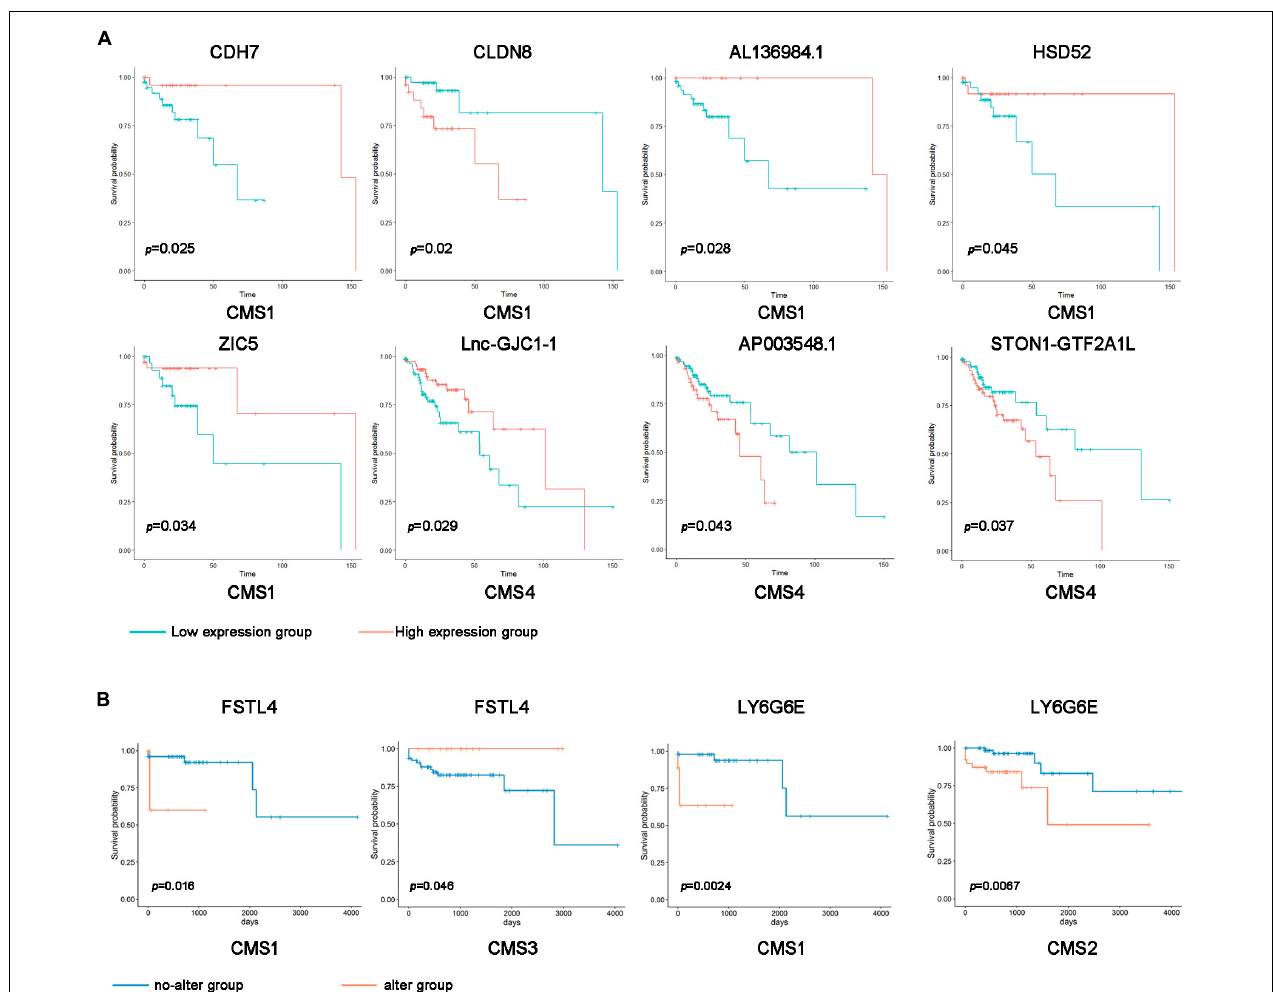
FIGURE 3 | Correlation of subtype-specific RNA expression with overall survival in colon cancer patients. (A) Kaplan–Meier survival curves were generated for subtype-specific RNAs by comparing groups with high (red line) and low (blue line) gene expression. p < 0.05 according to the log-rank test. (B) Kaplan–Meier survival curve of the subtype-specific genes with gene mutations. Orange indicates the gene alteration group, and blue indicates the no-alteration